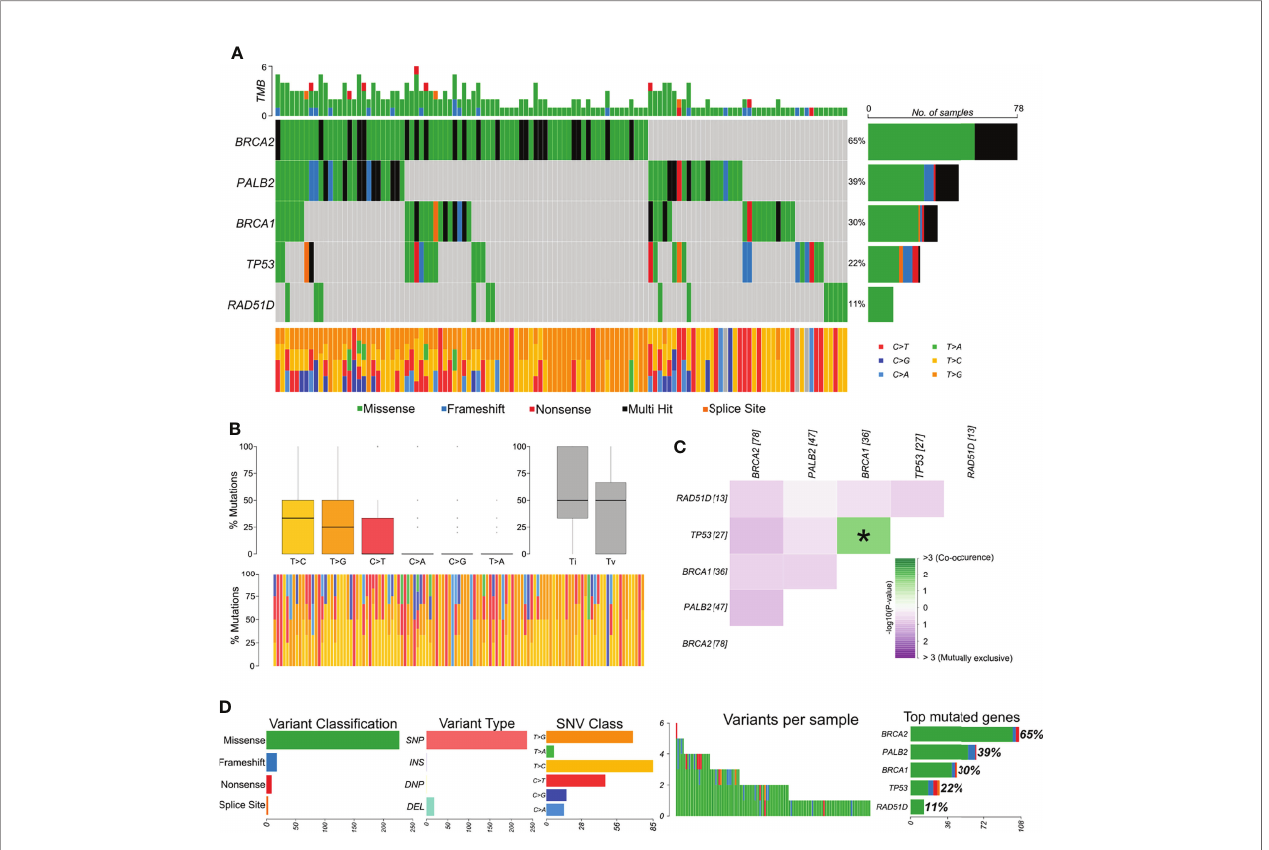
FIGURE 2 | Genomic landscape and potential associations between mutations identi fi ed in tumor breast cancer samples. (A) Oncoplot showing the mutational pro fi le of each gene in all tumor samples ordered by variant frequency. (B) Distribution of transitions and transversions in all tumor samples showing boxplot with overall summary of single-nucleotide variants (SNV) classi fi ed into six substitution classes, boxplot with distribution of SNVs classi fi ed into transitions (Ti) and transversions (Tv), and proportion of SNVs per sample classi fi ed into six substitution classes. (C) Co-occurrence or exclusive variant associations of the evaluated genes. (D) Panels with variant classi fi cation, type (SNP, single-nucleotide polymorphism; INS, insertion; DNP, double nucleotide polymorphism; DEL, deletion), SNV class, number of variants per sample, variant classi fi cation summary, and genes ordered by total number of variants. Color legend of panel A is the same for panels (B, D)